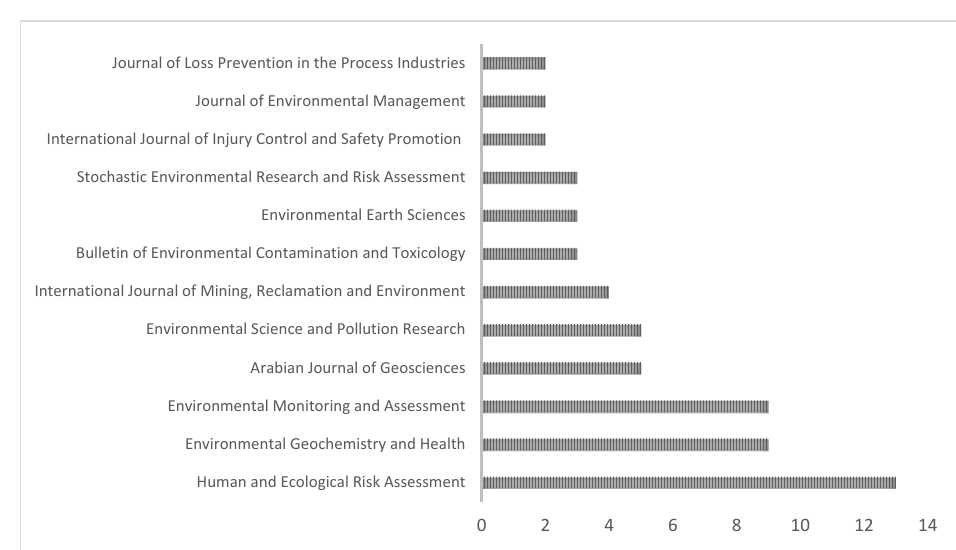
Figure 5. Number of papers by publication year.